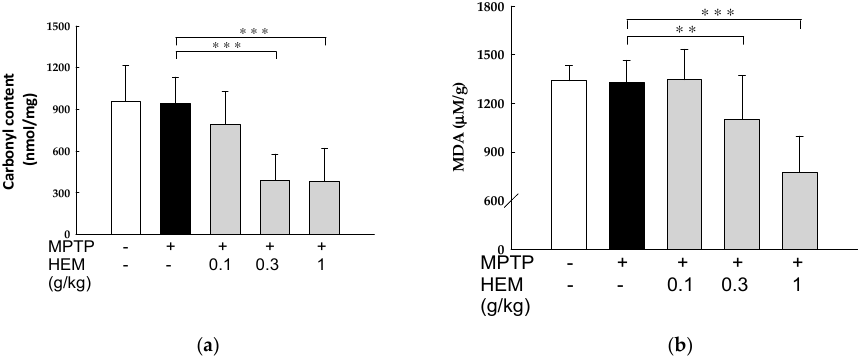
Figure 7. Effects of MPTP treatment in the presence or absence of HEM in the livers of mice on the ( a ) protein carbonyl content and ( b ) MDA levels. A significant decrease in the PC and MDA levels was found in the livers of mice treated with MPTP + HEM (0.3 and 1 g/kg) compared with the MPTP group. Values are expressed as mean ± SD. ** p < 0.01; *** p < 0.001 compared with the MPTP-treated group.